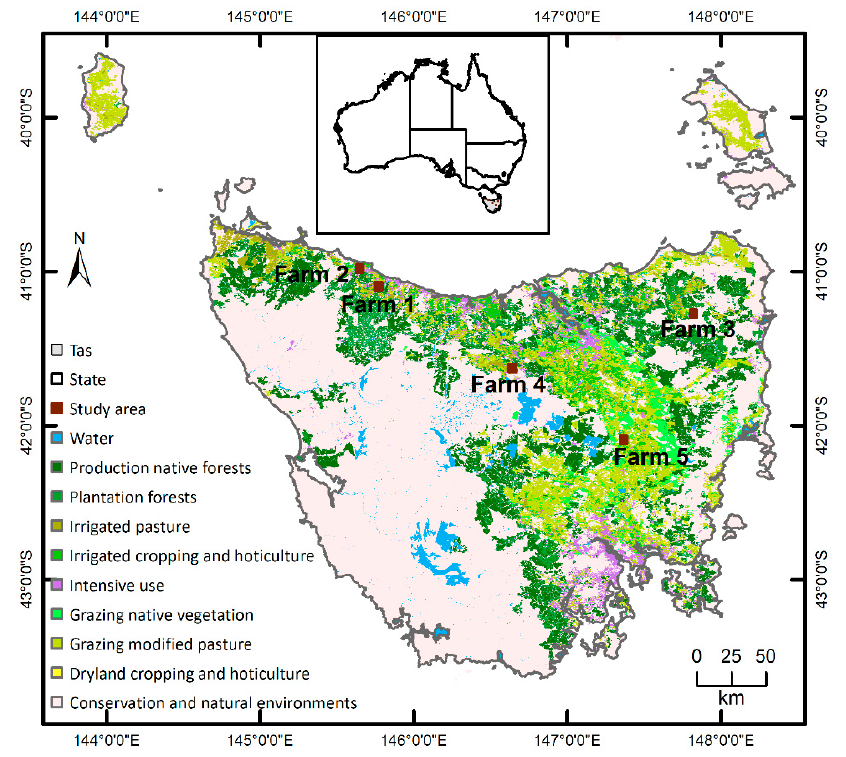
Figure 1. Locations of the study areas in Tasmania (Tas), Australia. Land use is based on the Catchment Scale Land Use of Australia 2018 (https://www.agriculture.gov.au/abares/aclump/land- use/catchment-scale-land-use-of-australia-update-december-2018 (accessed on 8 February